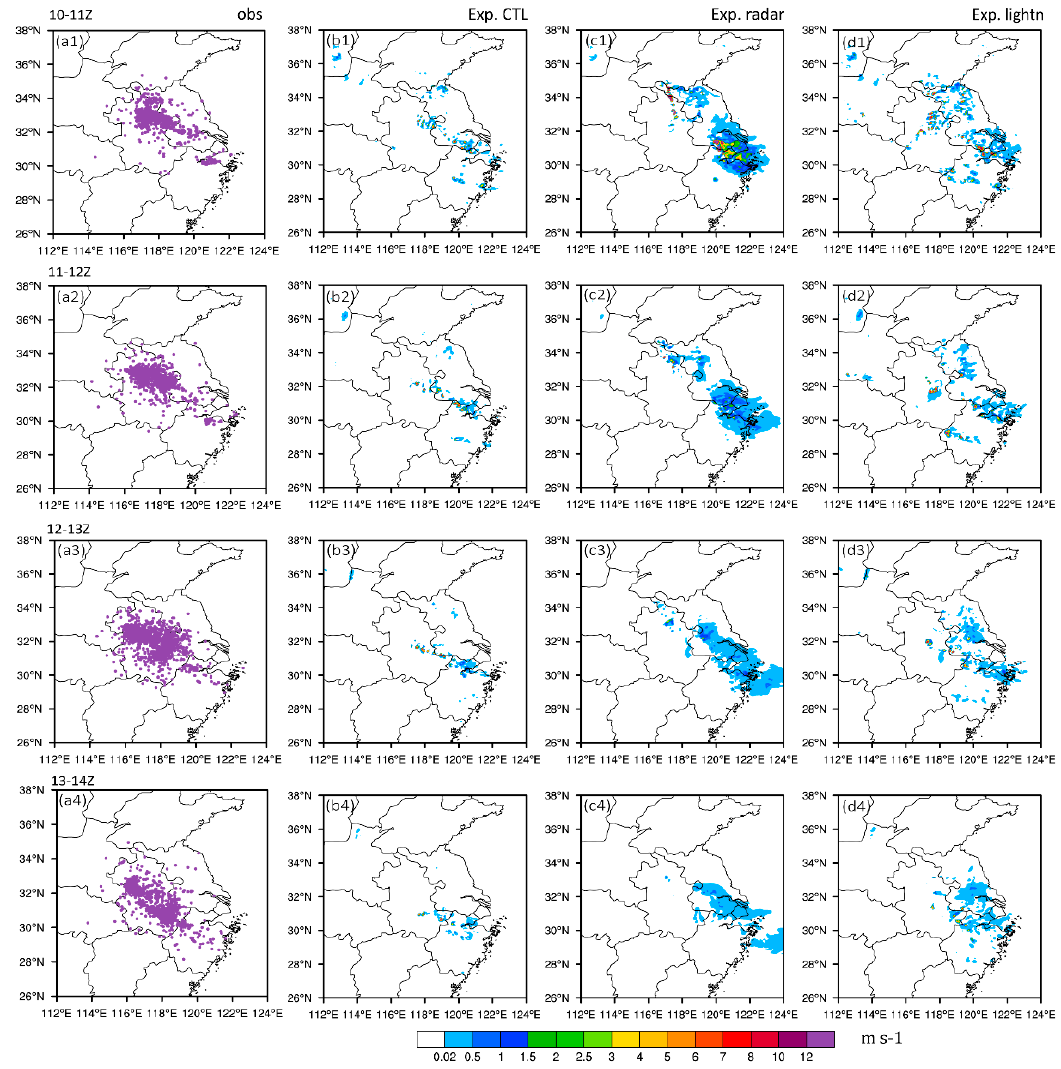
Figure 6. The observed cloud-to-ground lightning location ( a ) and the diagnosed lightning threat index (the graupel flux on − 15 °C isothermal plane, LTI 01, unit: m·s − 1 ) of ( b ) Exp. CTL, ( c ) Exp. radar and ( d ) Exp. lightn hourly from 1000 to 1400 UTC. Row 1 to 4 represents different time interval from 1000 to 1400 UTC.